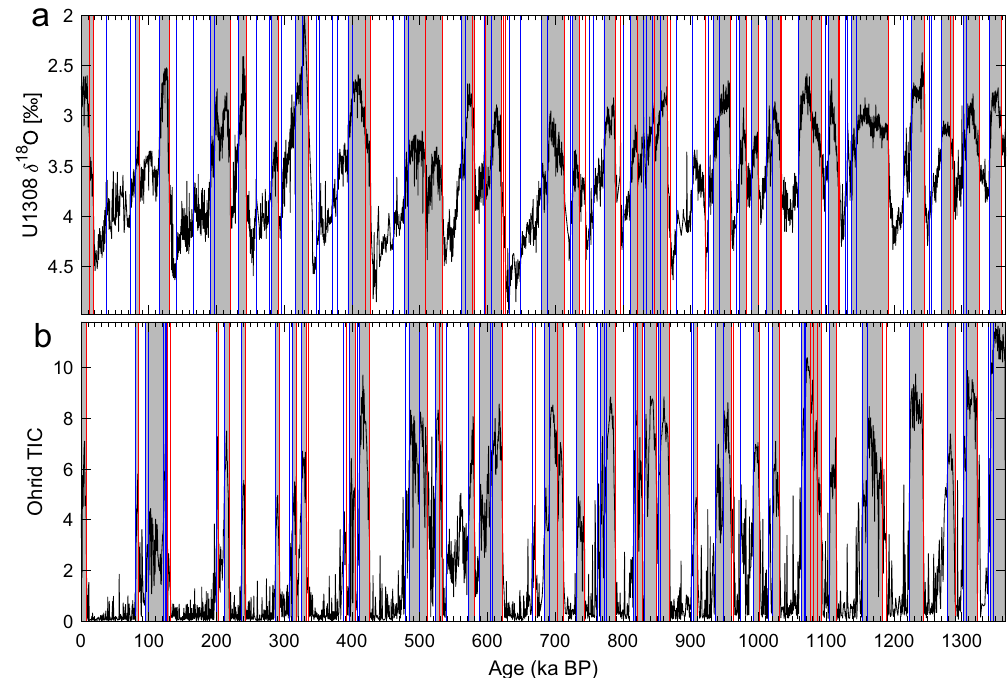
18 Figure 7. Comparison of the benthic Cibicidoides sp. δ O record in ( a ) the U1308 marine-sediment core 95 and ( b ) Lake Ohrid TIC 137 . Vertical lines represent transitions detected by our KS methodology 19 , with colors indicating the direction of the jumps. Grey bars correspond to interglacials (odd-numbered MISs) and white bars correspond to glacials (even-numbered MISs). The vertical axis in ( a ) is